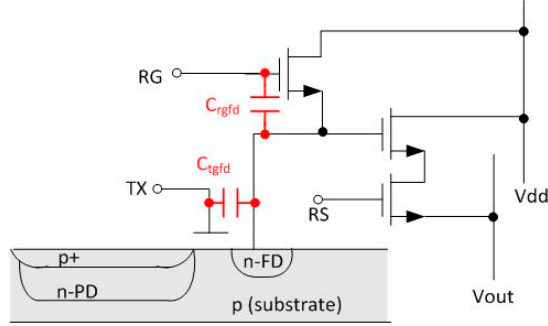
Figure 2. Pixel schematic with TG and RG coupling capacitances to FD.